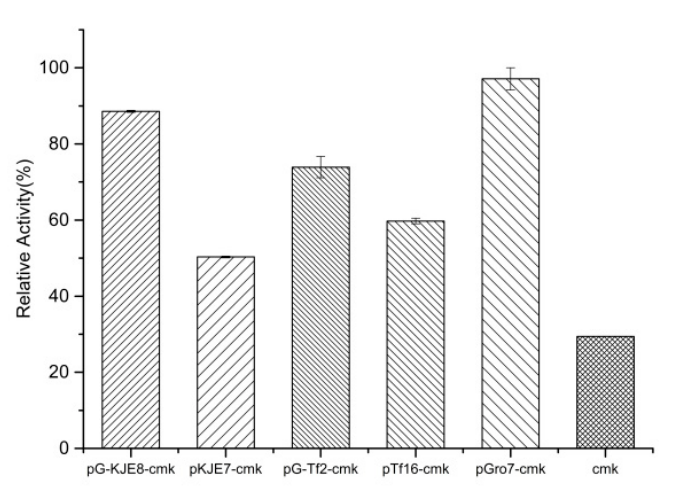
Figure 4. E ff ect of CMK co-expression with di ff erent molecular Figure 4. Effect of CMK co-expression with different molecular chaperones.